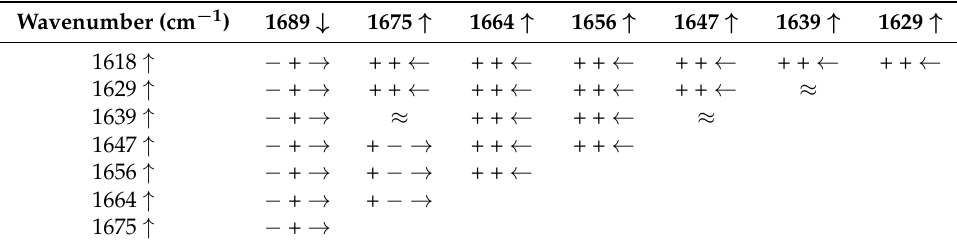
1675 ↑ − + → Column and row headings represent the x and y wavenumbers, respectively, from the 2D maps in Figure 8. Vertical arrows represent an increase ( ↑ ) or decrease ( ↓ ) in the band intensity as the temperature increased, as deduced from 1D spectra. The signs “+” and “–“ indicated positive and negative peaks in the 2D synchronous map and asynchronous map, respectively. The sign “ ≈ ” indicated there is no correlation peak is found in the asynchronous map which means both peaks change at the same time. Horizontal arrows indicate that the intensity change at y · cm − 1 occurs before ( → ) or after ( ← ) that at x · cm − 1